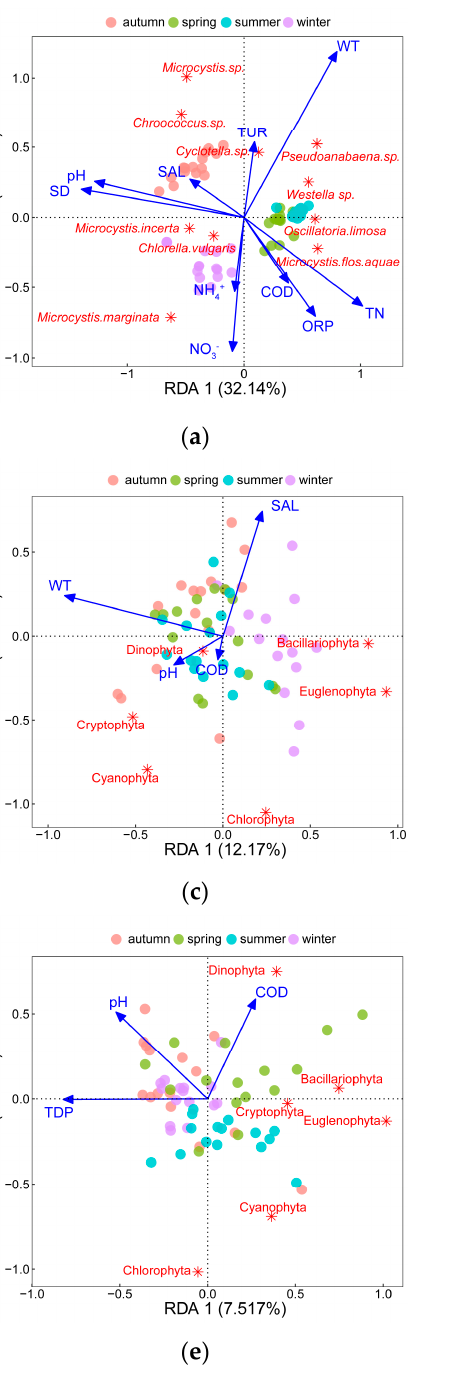
Figure 5. RDA of the top10 dominant phytoplankton species abundance and forward selected environmental factors: ( a ) RDA of phytoplankton species abundance; ( b ) RDA of phytoplankton species biomass; ( c ) RDA of phytoplankton species richness at phylum level; ( d ) RDA of phytoplankton community diversity at phylum level; ( e ) RDA of phytoplankton community evenness at phylum level.